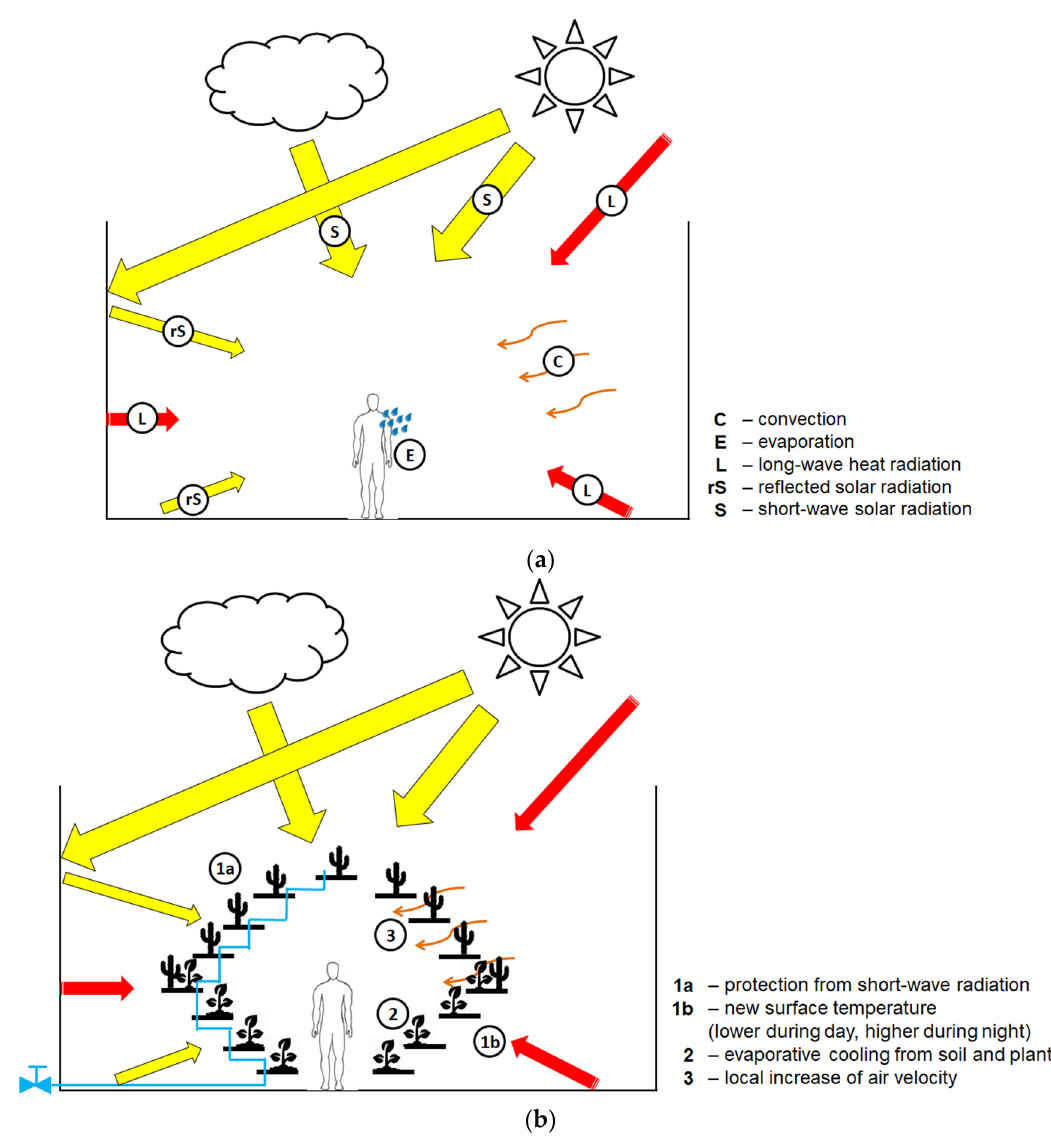
Figure 2. The Concept of the GS: ( a ) Factors that have an impact on the human body in a hot and dry urban area, ( b ) processes contributing to better thermal comfort in the green structure.